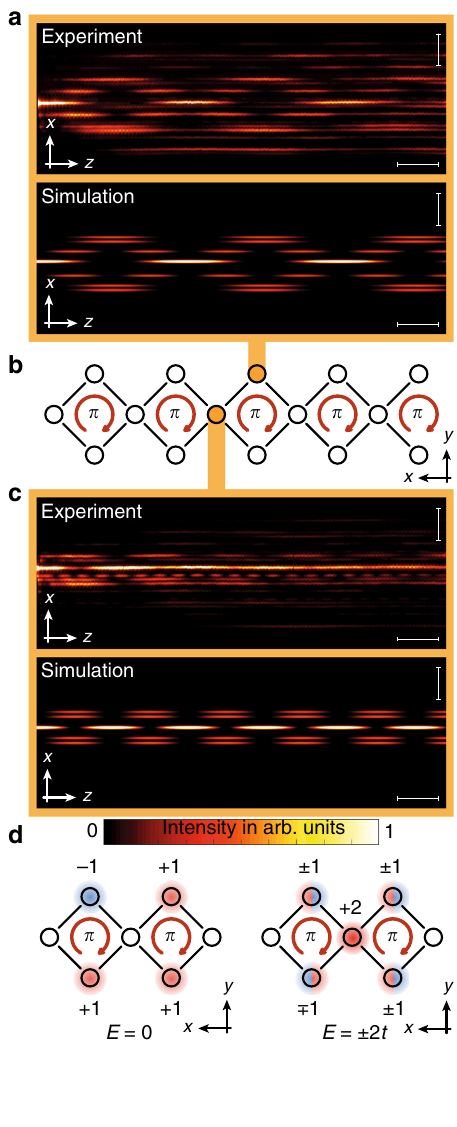
1Intensity in arb.